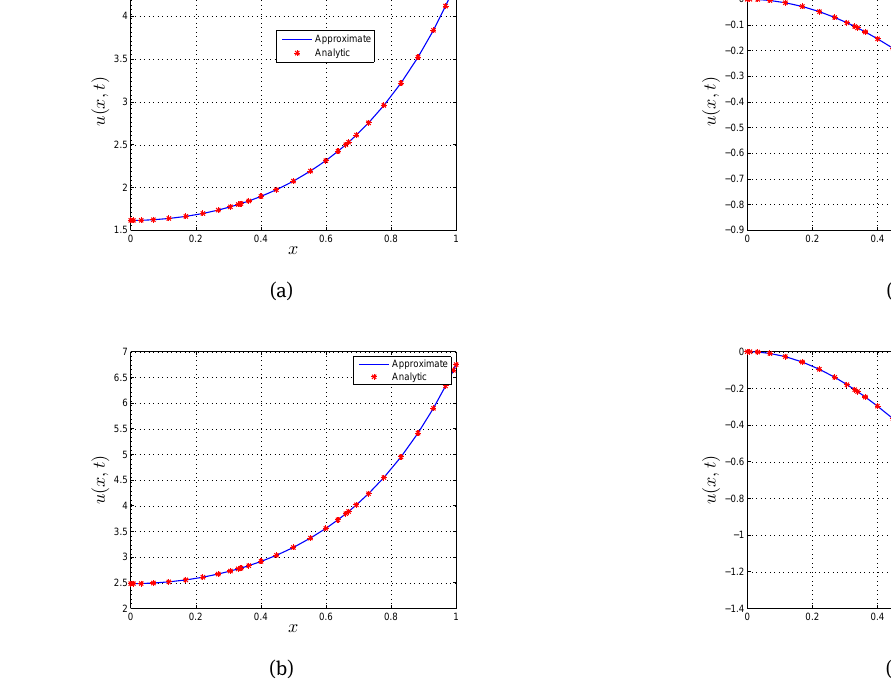
Figure 3: Analytical and approximate solution for example 2 at (a) t = 0.5 and (b) t = 2